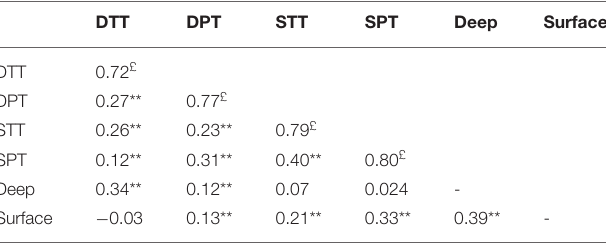
TABLE 3 | Pearson moment correlation between PE-SPQ and SPQ-2F. DTT DPT STT SPT Deep